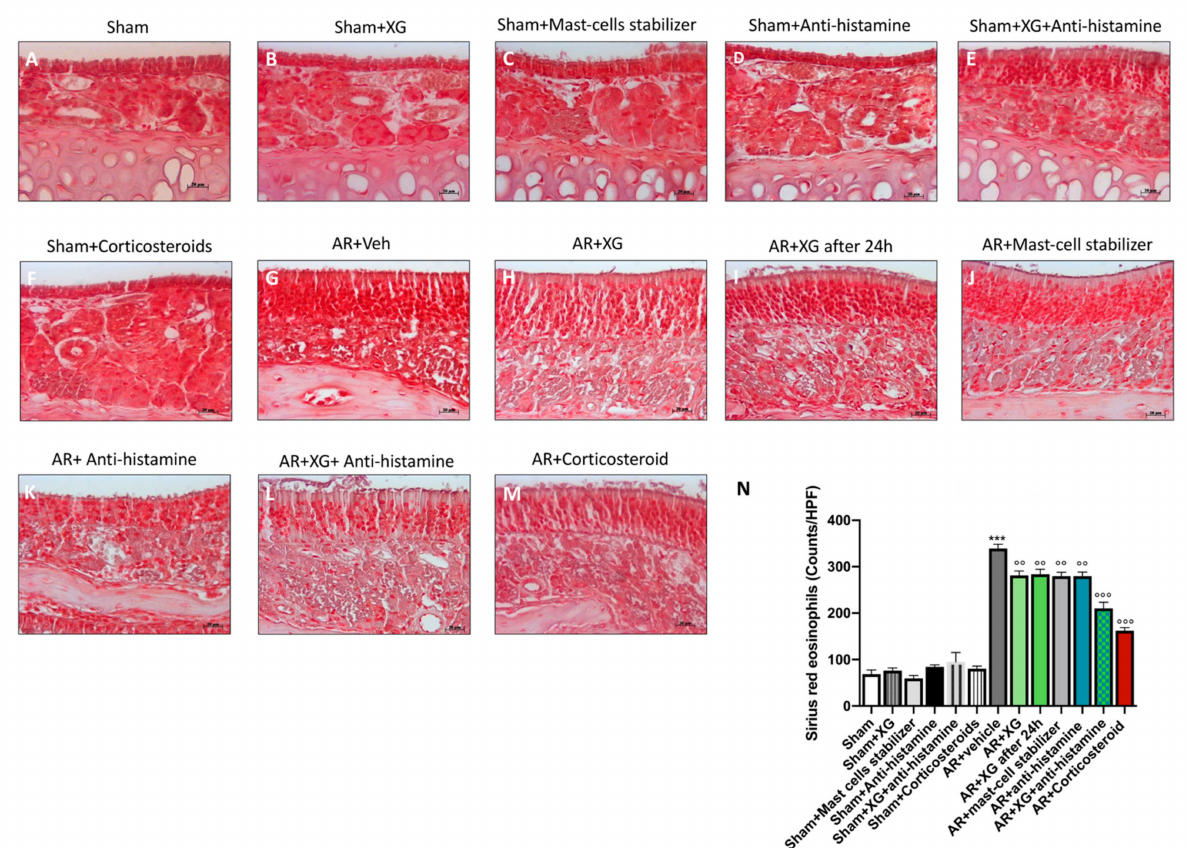
Figure 13. Effect of XG on eosinophils infiltration. Eosinophils count was increased in AR-mice ( G ) compared to the sham groups ( A – F , histological score N ). XG single treatments ( H , I , histological score N ) considerably reduced eosinophils infiltration with comparable efficacy to the to the antihistamine ( K , histological score N ) and mast-cell stabilizer ( J , histological score N ) treatments. Moreover, XG and antihistamine co-administration ( L , histological score N ) proved to decrease eosinophils infiltration, analogously to corticosteroid treatment ( M , histological score N ). Data are representative of at least three independent experiments. Values are means ± SEM. One-Way ANOVA test. *** p < 0.001 vs. Sham; ◦◦ p < 0.01 vs. AR + vehicle; ◦◦◦ p < 0.001 vs. AR + vehicle.